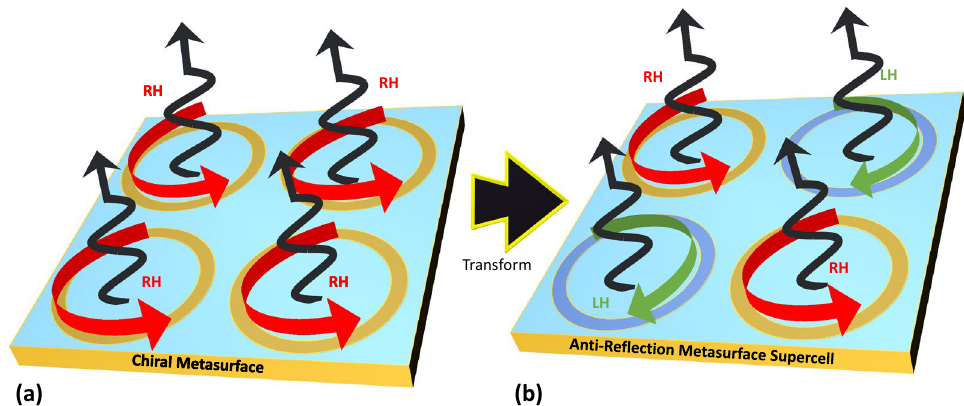
Figure 1. Schematic illustration of transformation of chiral reflecting metasurface cells consisting of four adjacent unitcells of anti reflecting metasurface supercell. Rotating arrows (left or right handed) on the surface represent current direction. Black arrows represent radiated fields emerging from each unit